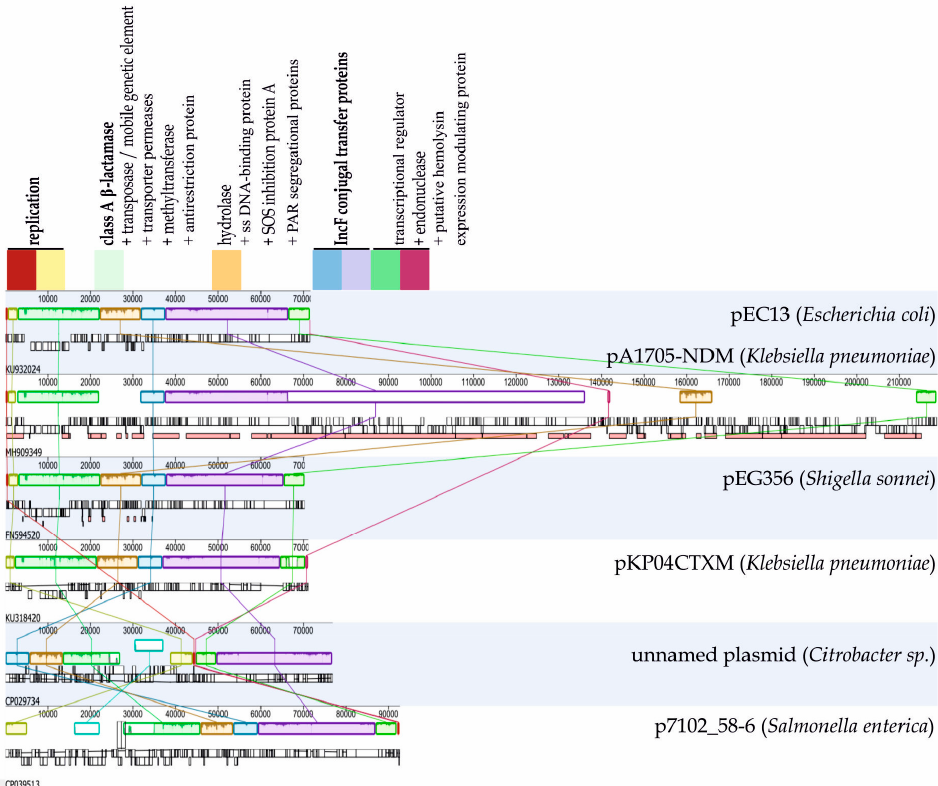
Figure 1. Plasmid map of conjugative pEC13. The predicted coding regions are marked in grey. Regions involved in the conjugation (blue), replication (green) and antibiotic resistance (orange) are marked.